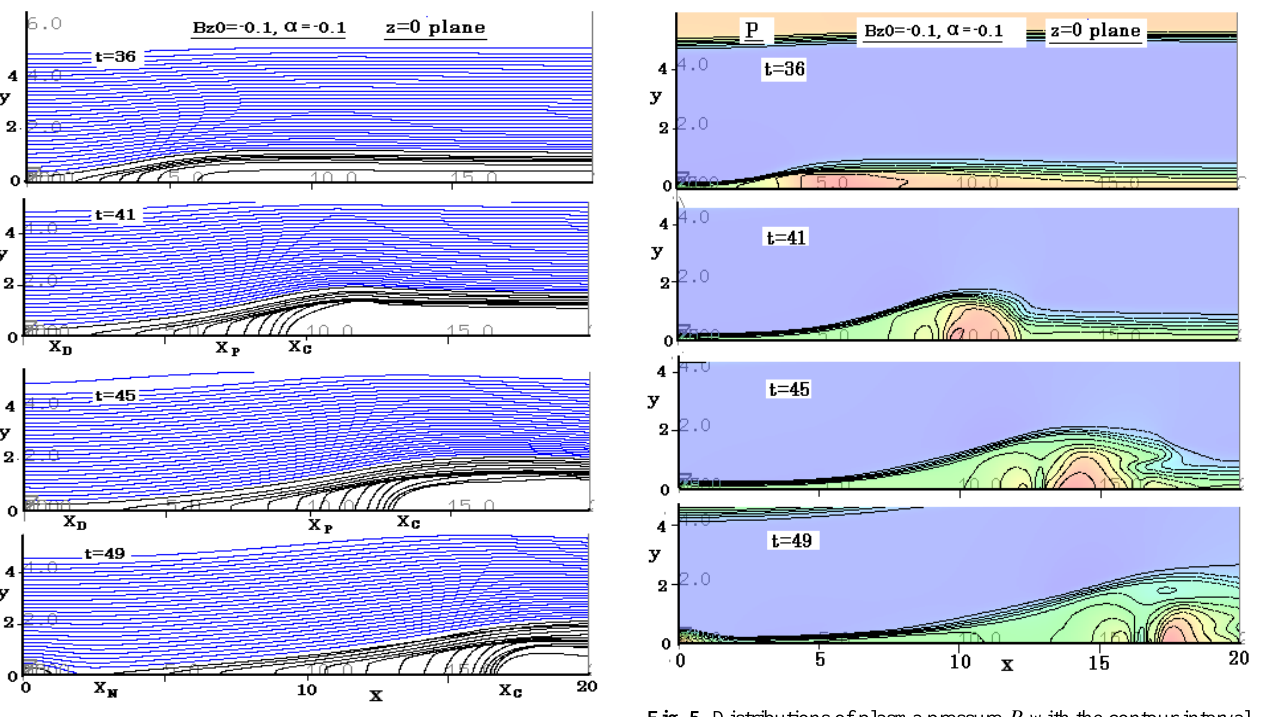
Fig. 4. Magnetic field lines passing through the y-axis and the re- Figure 4: Magnetic fleld lines passing through the y axis connected field lines passing through the x-axis, projected onto the z = 0 (x,y) plane, for the case of B z 0 = − 0 . 1 and α = − 0 . 1, where and the reconnected fleld lines passing through the x axis, the diffusion region boundary X D , the plasmoid backward end X P projected onto the z = 0( x; y ) plane, for the case of B z 0 = and the plasmoid center X C are indicated at t = 41 and 45; also, the 0 : 1 and fi = 0 : 1, where the difiusion region boundary X D , shifted X neutral line X N is indicated at t = 49. ¡ ¡ the plasmoid backward end X P and the plasmoid center X C are indicated at t = 41 and 45; also, the shifted X neutral line X N is indicated at t = 49.